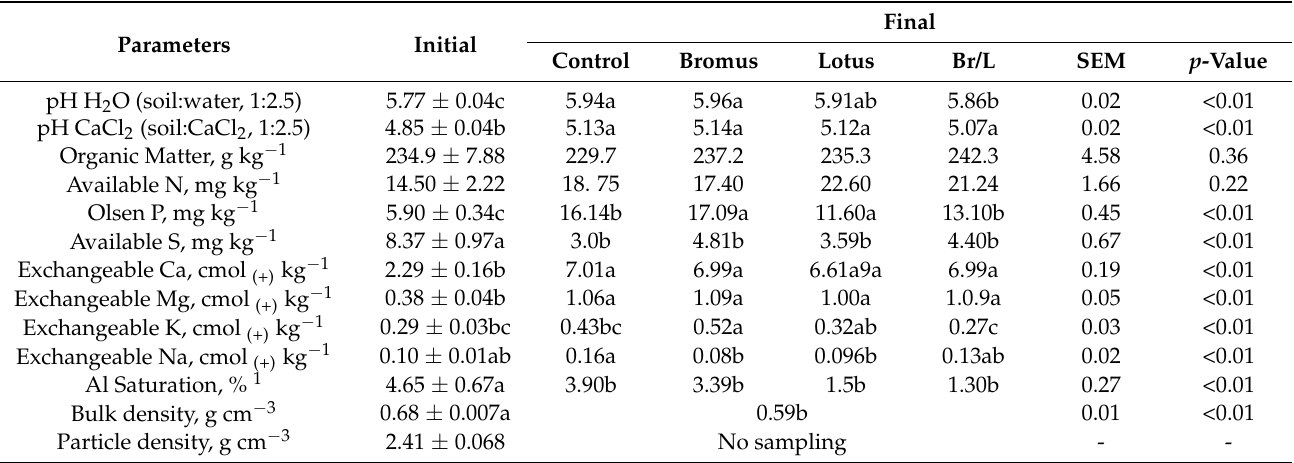
Table 1. Initial (07/08/2015, n = 4 pseudoreplicates) and final (11/10/2017, n = 5) soil characterization for type of pasture (0–20 cm). Initial values ± standard error of the